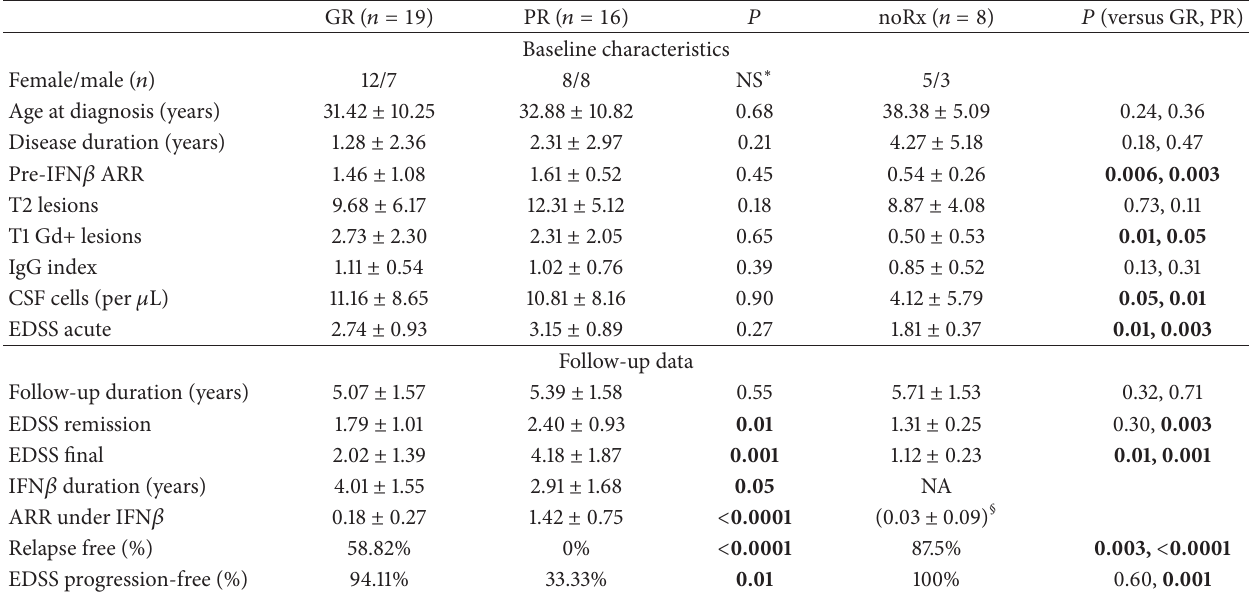
Table 3: Data of study subjects separated in treatment response